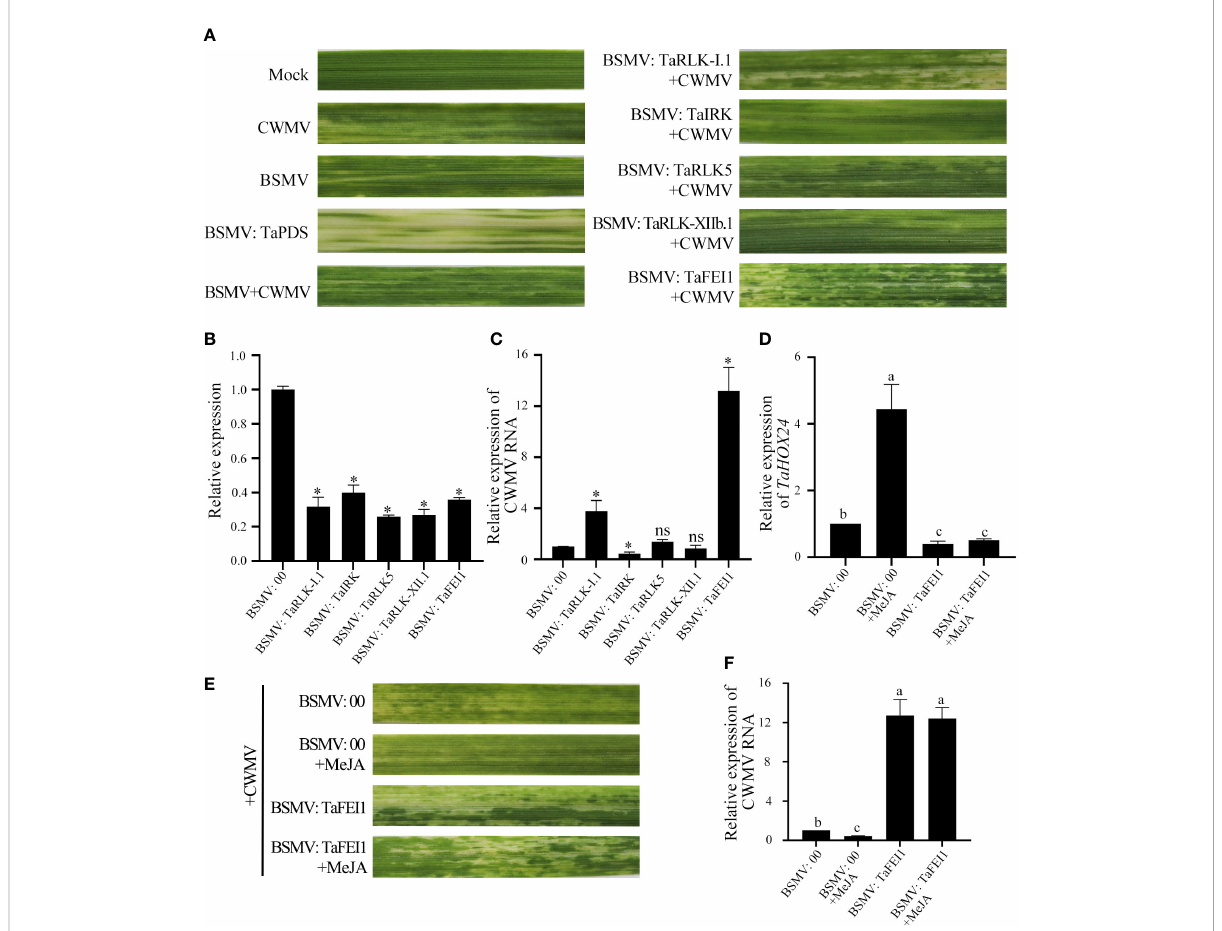
FIGURE 8 TaLRR-RLKs was involved in wheat resistance to CWMV infection. (A) Mild chlorotic mosaic symptoms were observed at 40 dpi on leaves inoculated with BSMV: 00, BSMV: TaPDS, BSMV: TaRLK-I 1+CWMV, BSMV: Ta Ⅰ RK +CWMV, BSMV: TaRLK5 +CWMV, BSMV: TaRLK-XII b.1+CWMV, BSMV: TaFEI1 +CWMV, respectively. Mock, wheat leaves treated with 1×Fes buffer. Photographs were taken at 40 dpi. (B) Relative expression of TaLRR-RLKs during the interaction between TaLRR-RLKs -silencing plans and CWMV. (C) CWMV RNA accumulation in TaLRR-RLKs-silencing was analyzed by qRT-PCR using CWMV CP speci fi c primers. (D) Relative expression of MeJA response gene TaHOX24 in TaFEI1-silencing plants under MeJA treatment. (E) Mild chlorotic mosaic symptoms were observed on leaves inoculated with BSMV: 00+CWMV or BSMV: TaFEI1 +CWMV under MeJA treatment. Photographs were taken at 40 dpi. (F) The accumulation of CWMV RNA accumulation in TaFEI1-silencing plants under MeJA treatment was determined by qRT-PCR. For all qRT-PCR, the values were normalized to those for TaCDC and are presented as fold changes relative to that in BSMV: 00. Asterisks indicate signi fi cant differences between that in TaLRR-RLKs -silencing plants and mock using Student ’ s t-test or the Tukey ’ s test (P < 0.01). ns, no signi fi cant